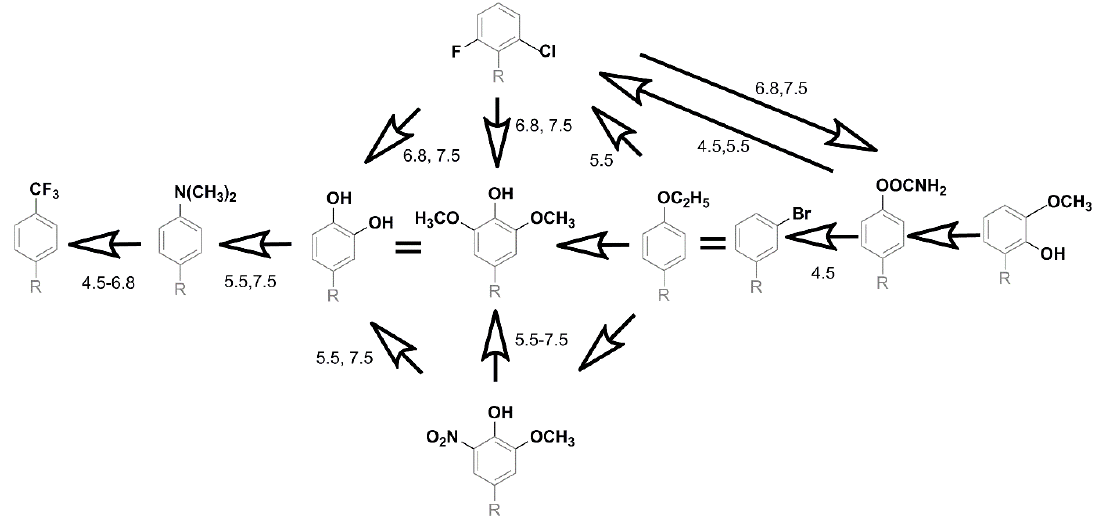
Figure 6. Summary of the differences in copper reduction among the tested compounds. The direction of the arrows shows more active compounds. The numbers represent pH at which the differences were observed.